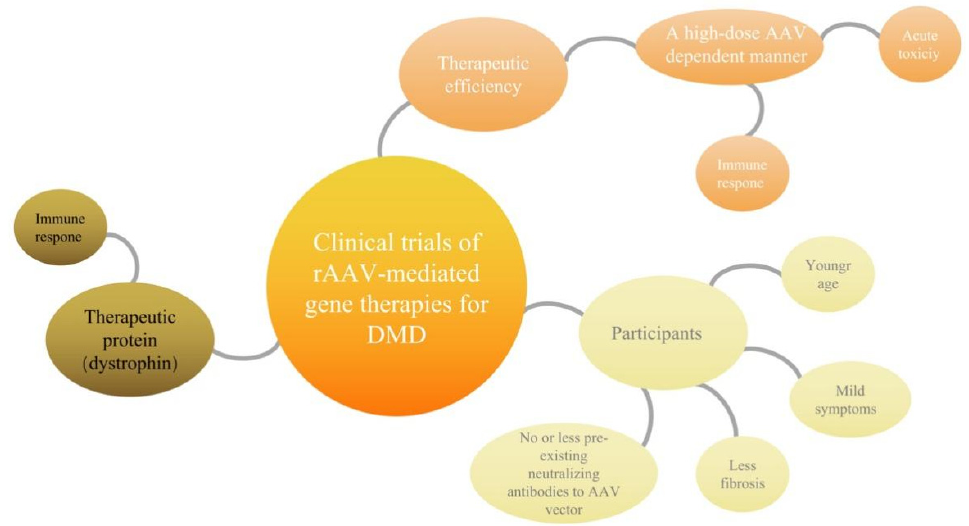
Figure 2. Possible bottlenecks of clinical trials of rAAV-mediated gene therapies for DMD. The possible bottlenecks of the rAAV-mediated mini/micro-dystrophin gene therapy can be summarized into three types. One is that the therapeutic effects are highly dependent on the high dose of rAAV; however, the immune response to high dose systemic rAAV may trigger acute toxicity. The second